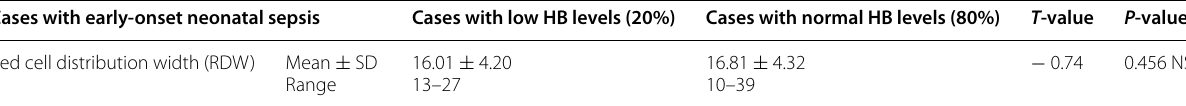
NS not significant